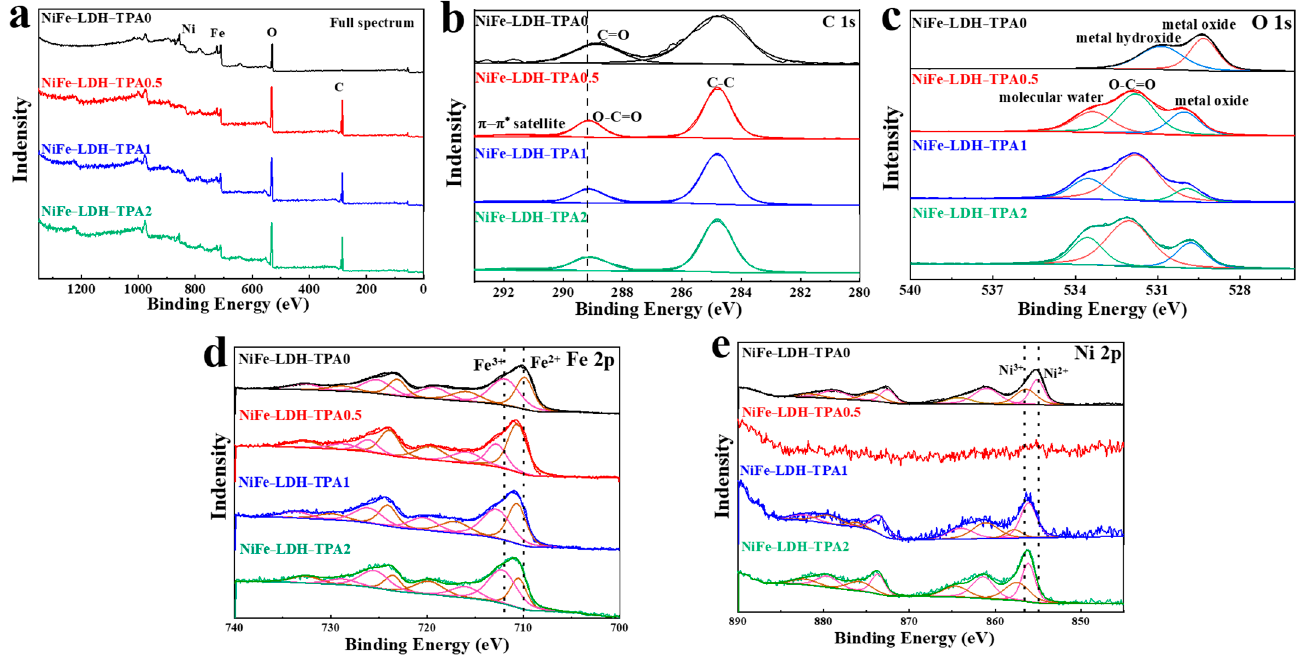
Figure 3. XPS measurements. ( a ) XPS full spectrum, high-resolution XPS spectra of ( b ) C 1s, ( c ) O 1s, ( d ) Fe 2p, and ( e ) Ni 2p for NiFe-LDH-TPA0 (black line), NiFe-LDH-TPA0.5 (red line), NiFe-LDH-TPA1 (blue line), and NiFe-LDH-TPA2 (green line).